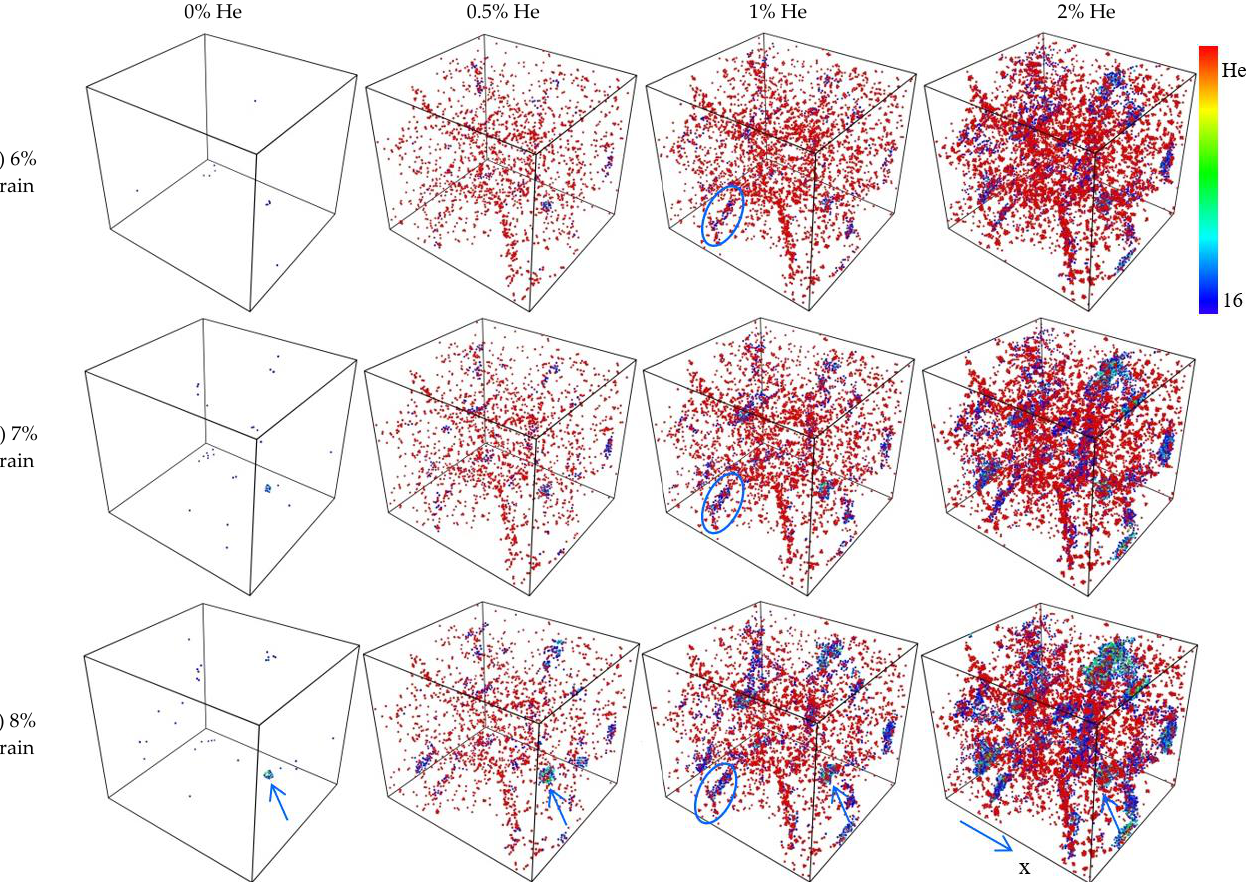
Figure 3. The generation of crack in the model deformed to ( a ) 6% strain; ( b ) 7% strain; ( c ) 8% strain. The concentration of He are label in the picture. The red represents He atom and the Fe atoms are colored according to atomic volume, see the color bar. The loading direction is parallel to x-axis.